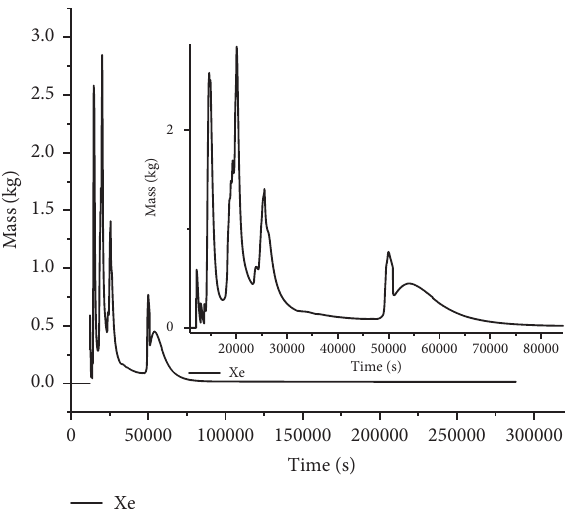
Figure 6: Release of Xe in the primary circuit system.